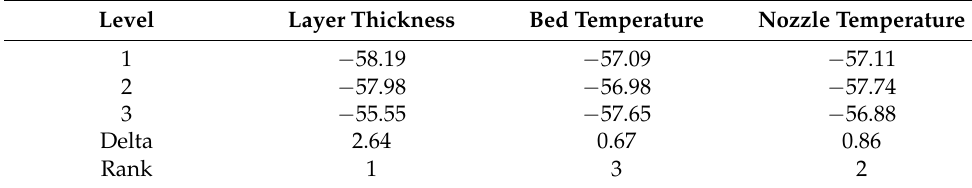
Table 7. S/N ratios response table for FEM predicted H.